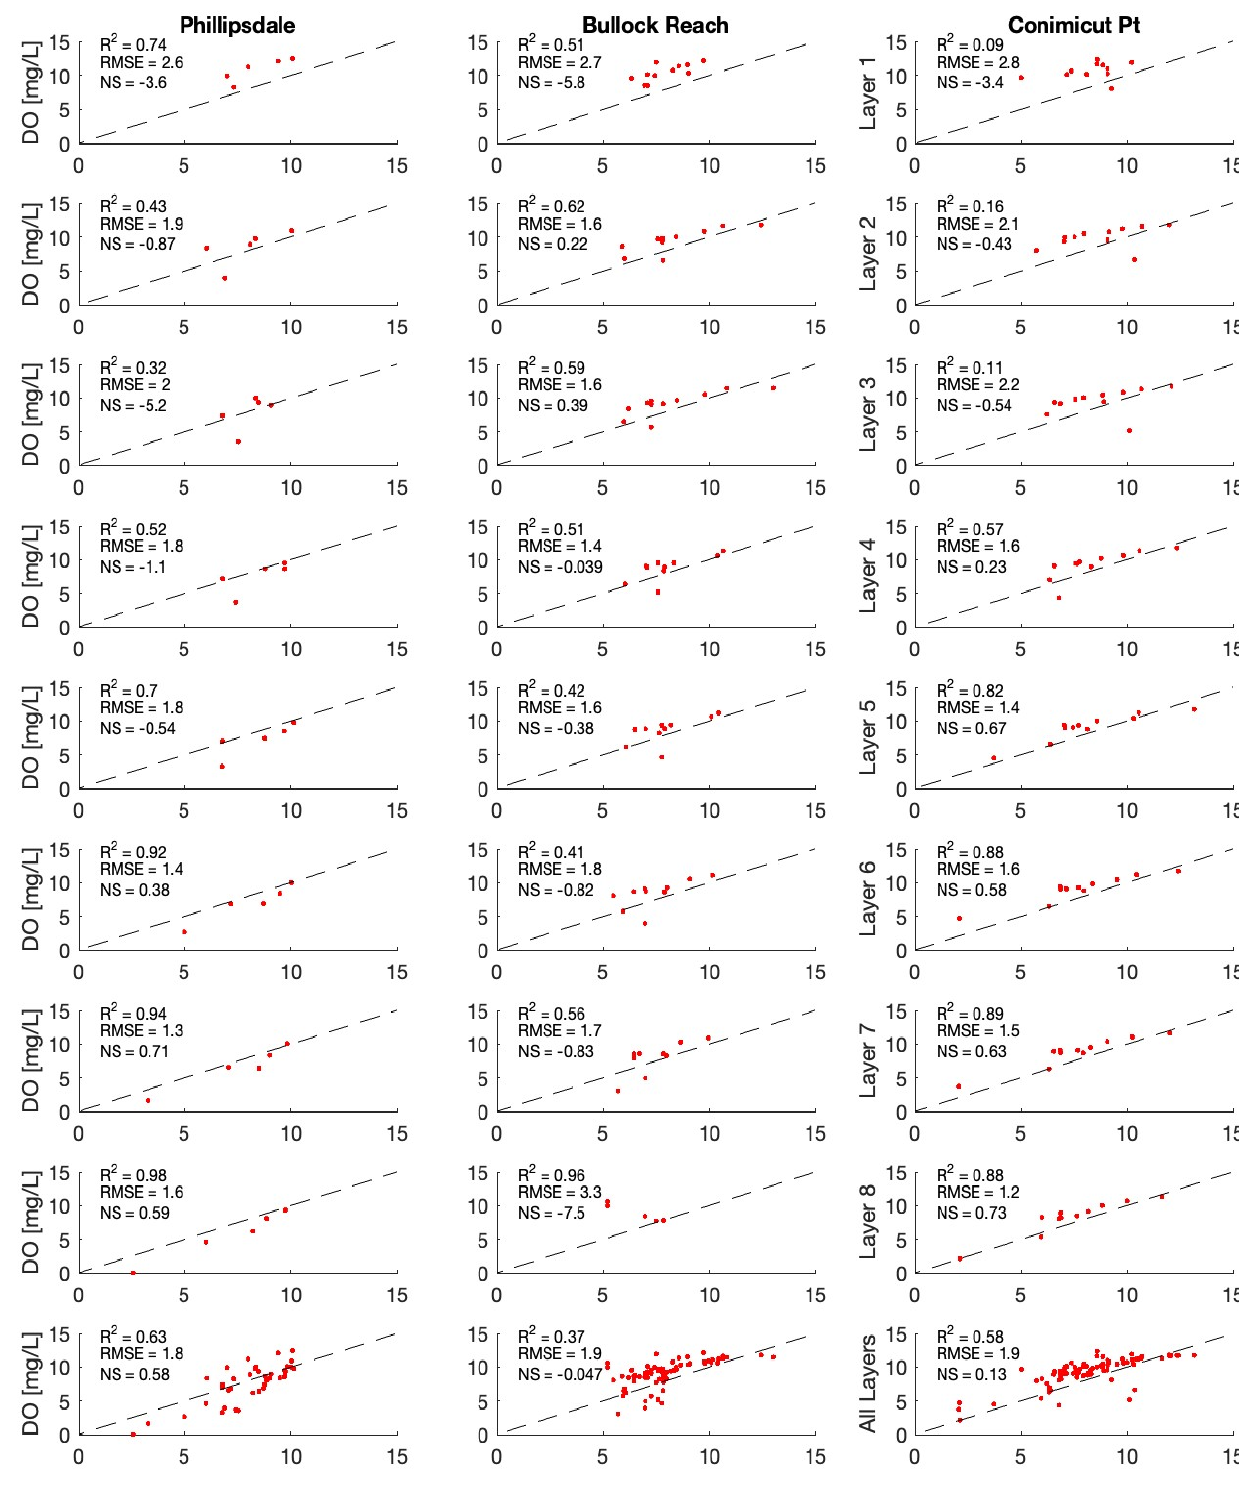
Figure 7. Simulated WASP vs. Observed Discrete Depth Profile Dissolved Oxygen Concentrations with Calculated R 2 , Root Mean Square Error (RMSE), and Nash–Sutcliffe (NS). Simulated WASP vs. Observed Sonde data. First 3 columns are DO at Surface, Mid-depth, and Bottom. Columns 4 and 5 are chl a at surface and mid-depth. Rows are locations from north to south. Simulated WASP vs. Grab Samples for DO. Columns are 3 locations with available depth profile DO data. First 8 rows are water column layer, row 9 is the combining all layers of data.